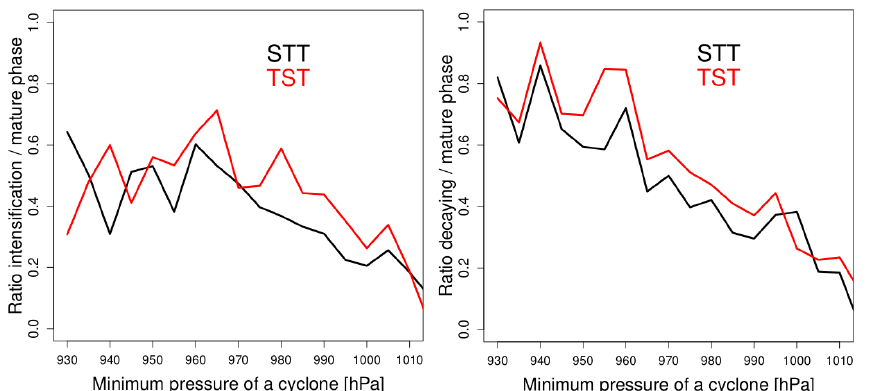
Figure 10. As Fig. 9 but for TST instead of STT.